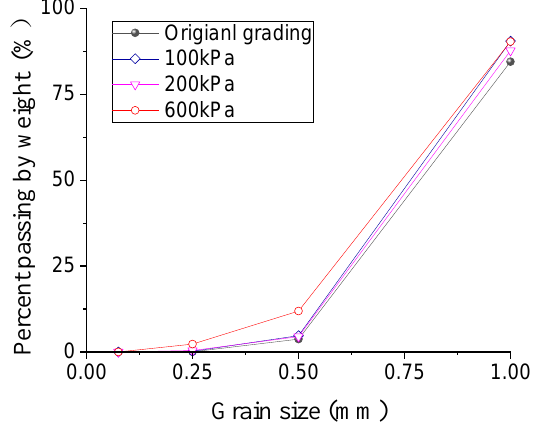
Figure 10. Grain size distribution of unstabilized calcareous sand after triaxial tests.